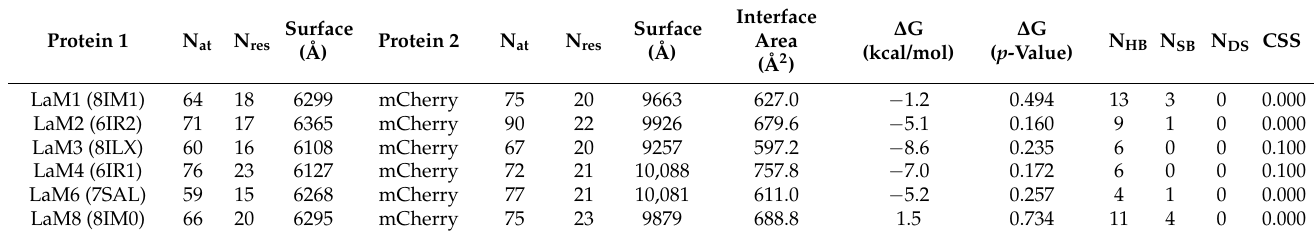
Table 6. Analysis of protein buried surface in the complex by PISA on